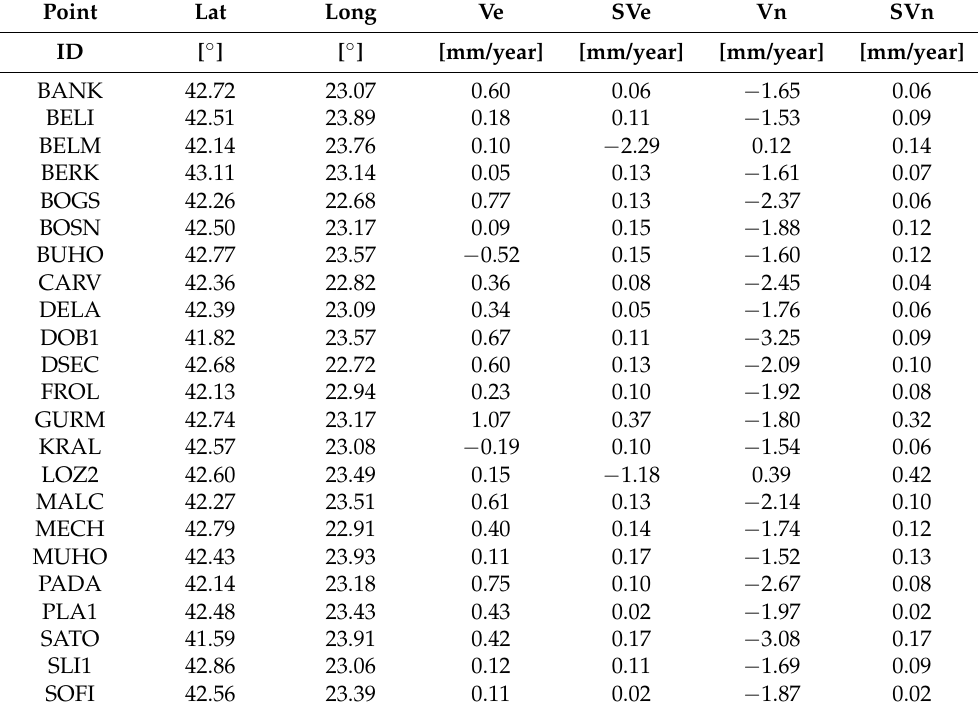
Table 3. Estimated horizontal velocities relative to Eurasia, ETRF2014.